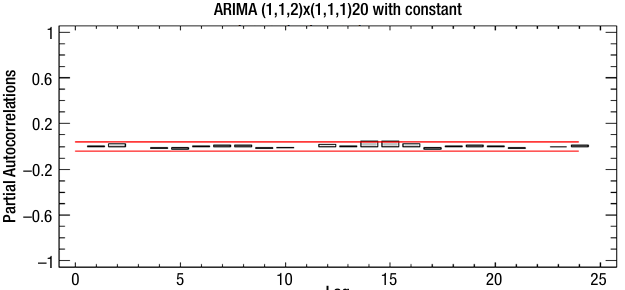
Fig. 8a. Residual autocorrelations for adjusted time series of Overnight 2000–2008